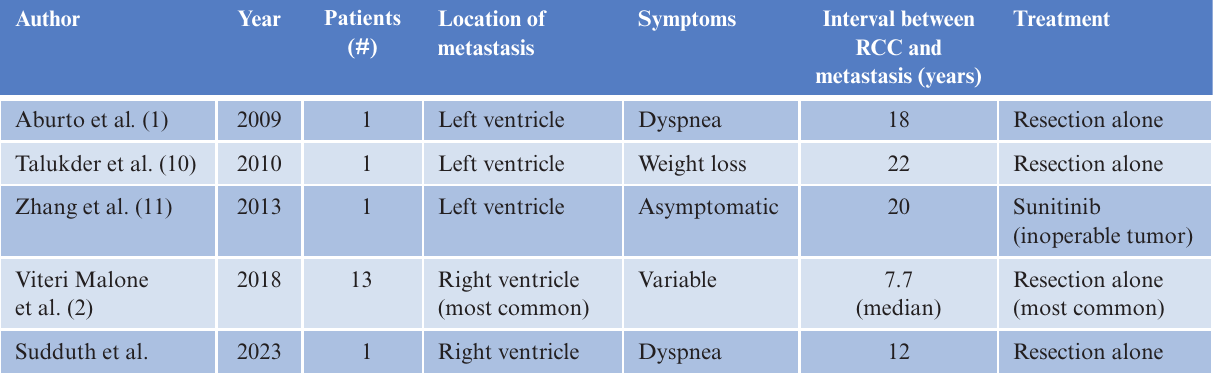
Table 1: Review of the literature identified 4 reports of delayed presentation of isolated cardiac metastasis from renal cell